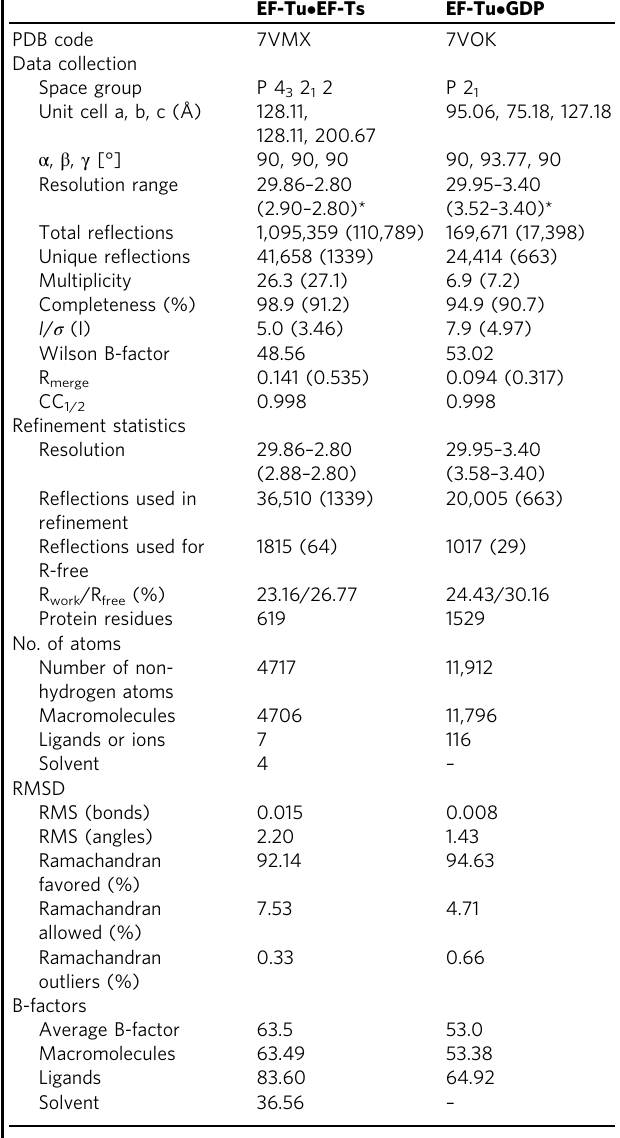
Table 1 Data collection and re fi nement